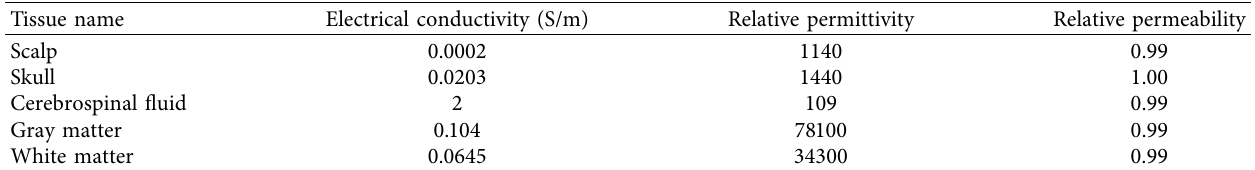
Table 1: E lectromagnetic properties of the five different anatomical layers at an operating frequency of 2500Hz [21] .